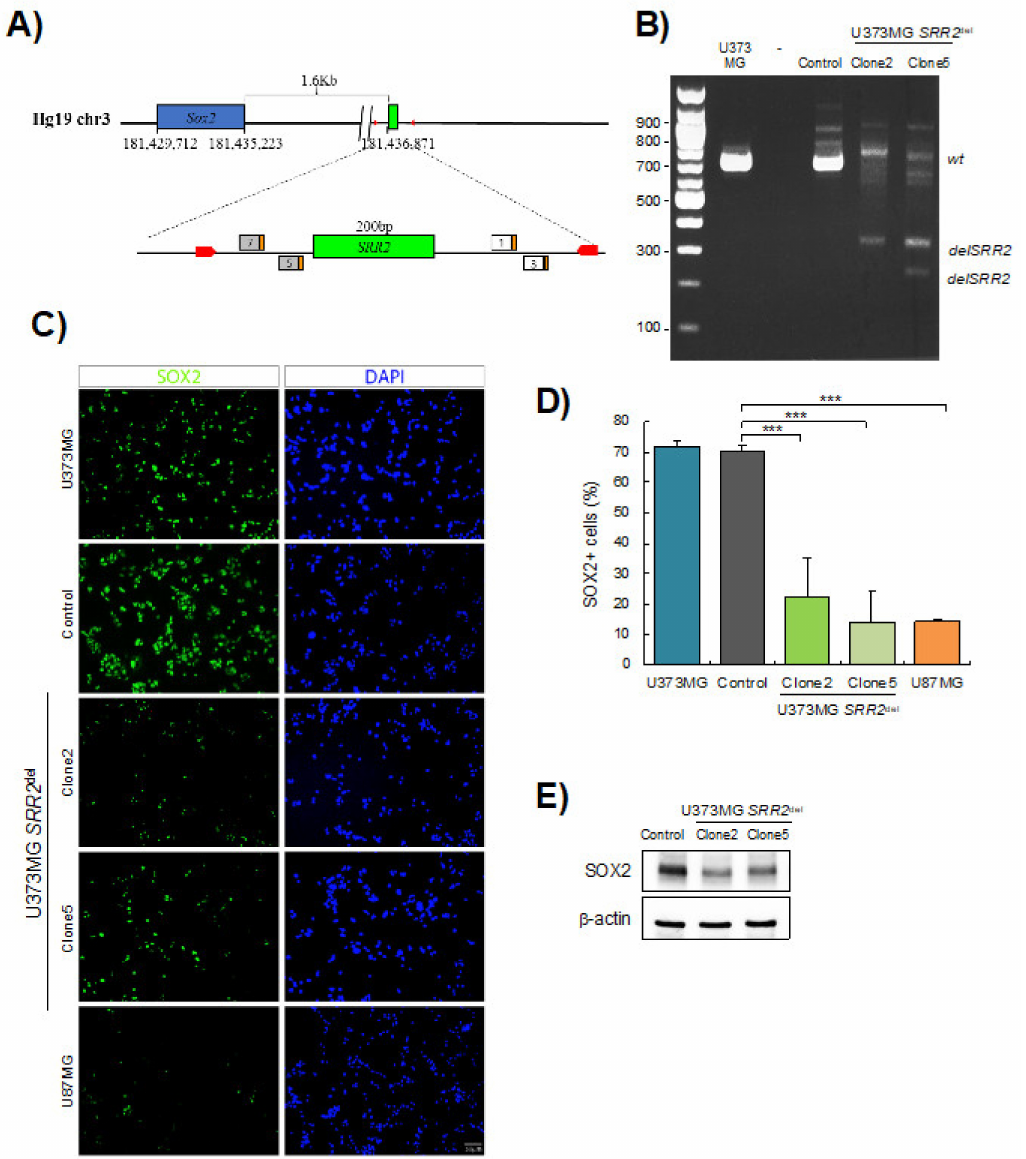
Figure 2. SOX2 levels are reduced in SRR2 -deleted cells. ( A ) Schematic representation of SOX2 and SRR2 downstream. At the bottom, magnification of the SRR2 surrounding region. SRR2 (200 bp) is marked by a green box. The location of the guides in 5 (cid:48) (guide 7 and guide 5) and in 3 (cid:48) (guide 1 and guide 3) single guide RNA (sgRNA) is labeled including their protospacer adjacent motif (PAM) sequence (orange box). Primers used for genotyping the deletion are marked with red arrows. ( B ) Gel electrophoresis showing loss of SRR2 in U373MG SRR2 del clone2 and clone5 vs. control or parental cell line U373MG after transfection with guides and Cas9. ( C ) Representative images of SOX2 immunofluorescence (scale bar = 50 µ m) and ( D ) quantification of SOX2-positive cells in U373MG (parental cells), control cells, U373MG SRR2 del clone2 and clone5 and U87MG cells ( n = 3). ( E ) Representative immunoblot of SOX2 in control, clone2 and clone5 cells. The statistical significance was obtained with the Student’s t -test (*** p <